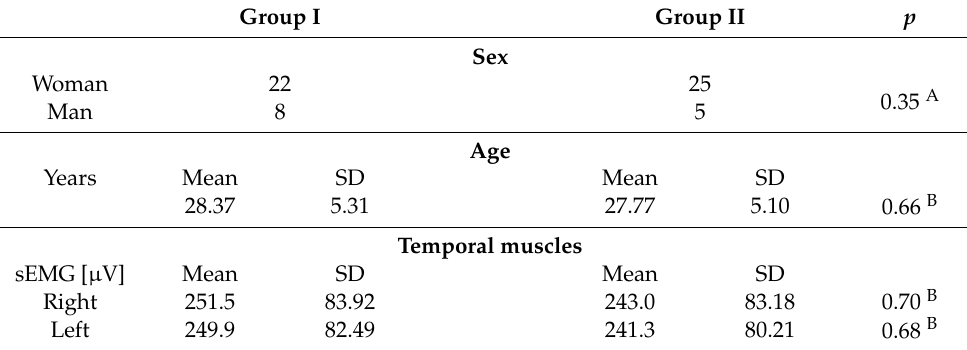
Table 1. Comparison of the distribution of the sex, age, mean values of electric potentials [ µ V] of the anterior part of temporal muscles and masseter muscles, and the intensity of spontaneous pain in the masticatory muscles in the VAS score assessed during the first examination between group I and group